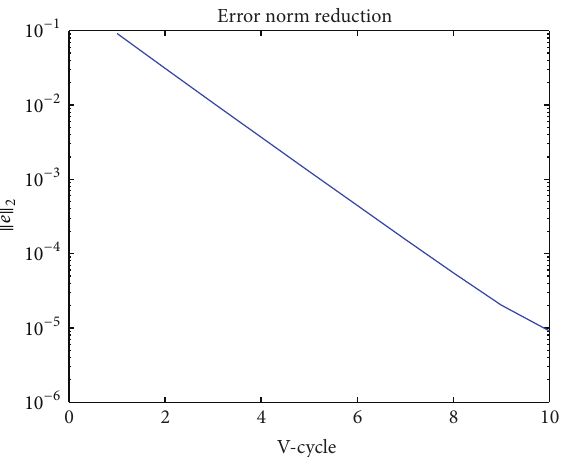
Figure 4: The error graph. The error vector 𝑒 𝑖𝑗 = 𝑢 𝑖𝑗 − V 𝑖𝑗 and 𝑁 = 6 are the number of nodes and ℓ = 10 for Example